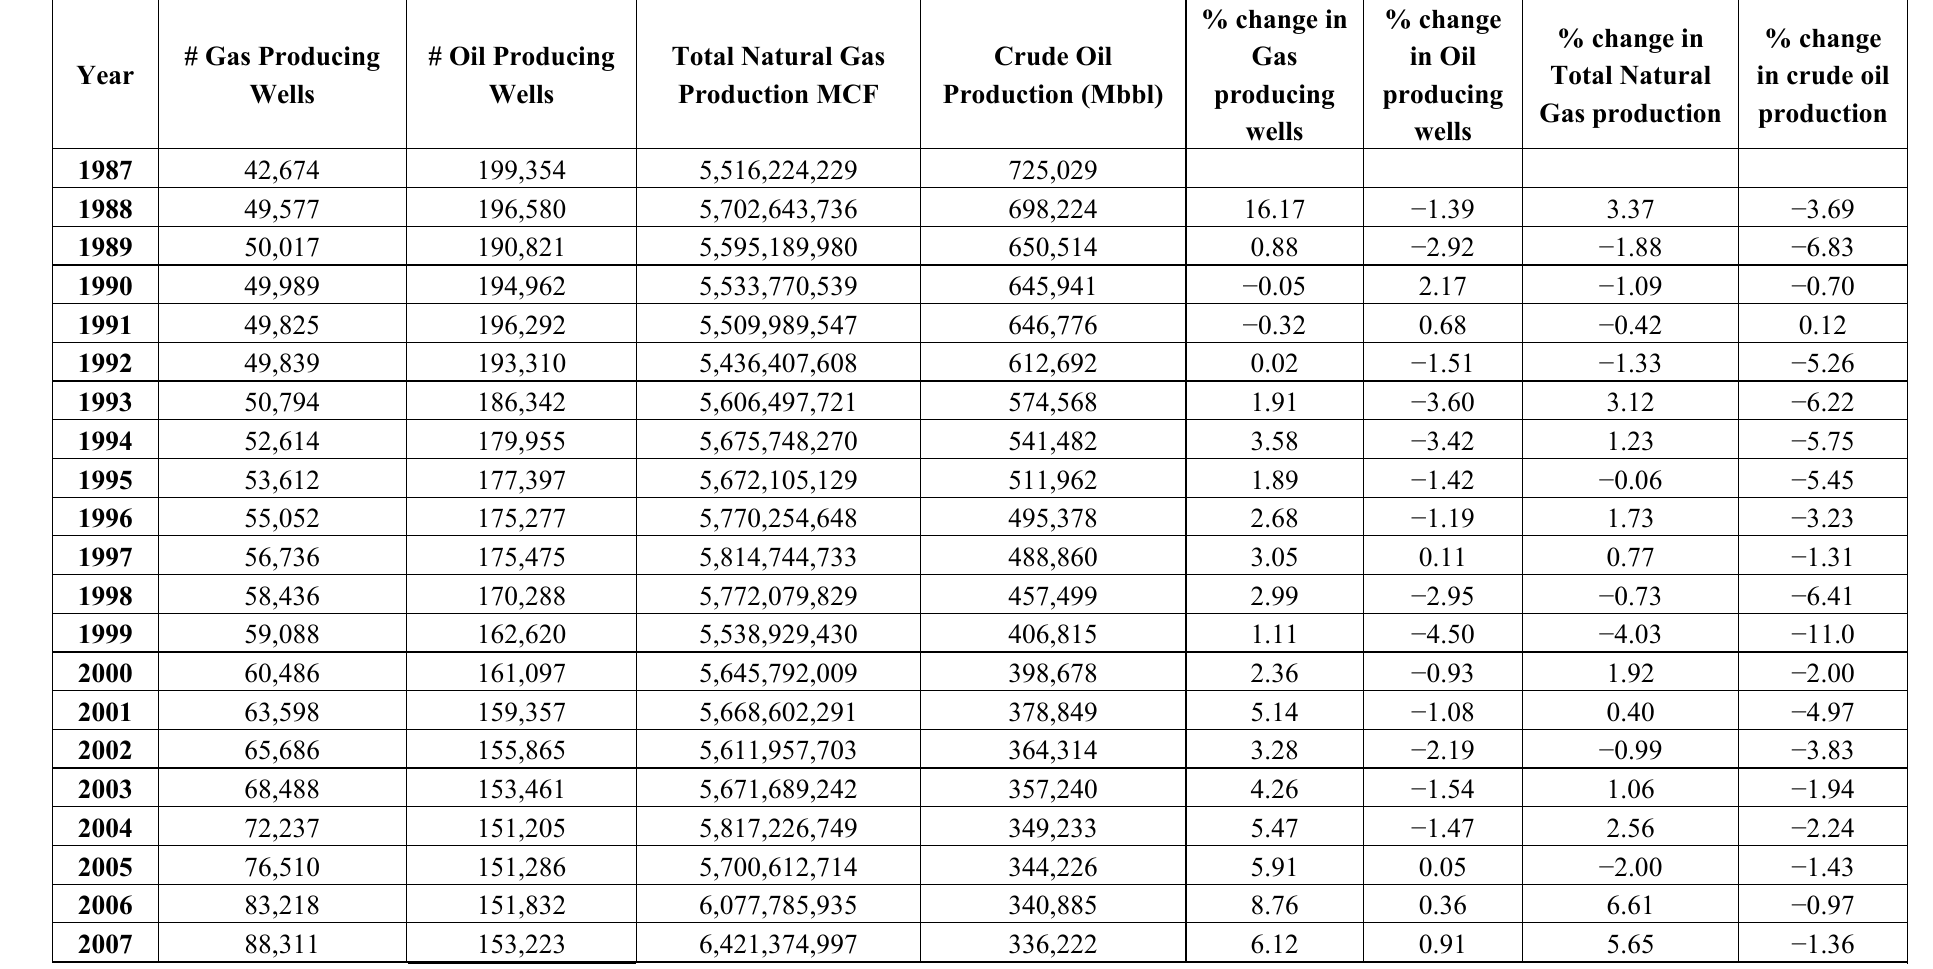
Table 3. Number of Oil and Gas Producing Wells for Texas 1987–2007 and Percentages of